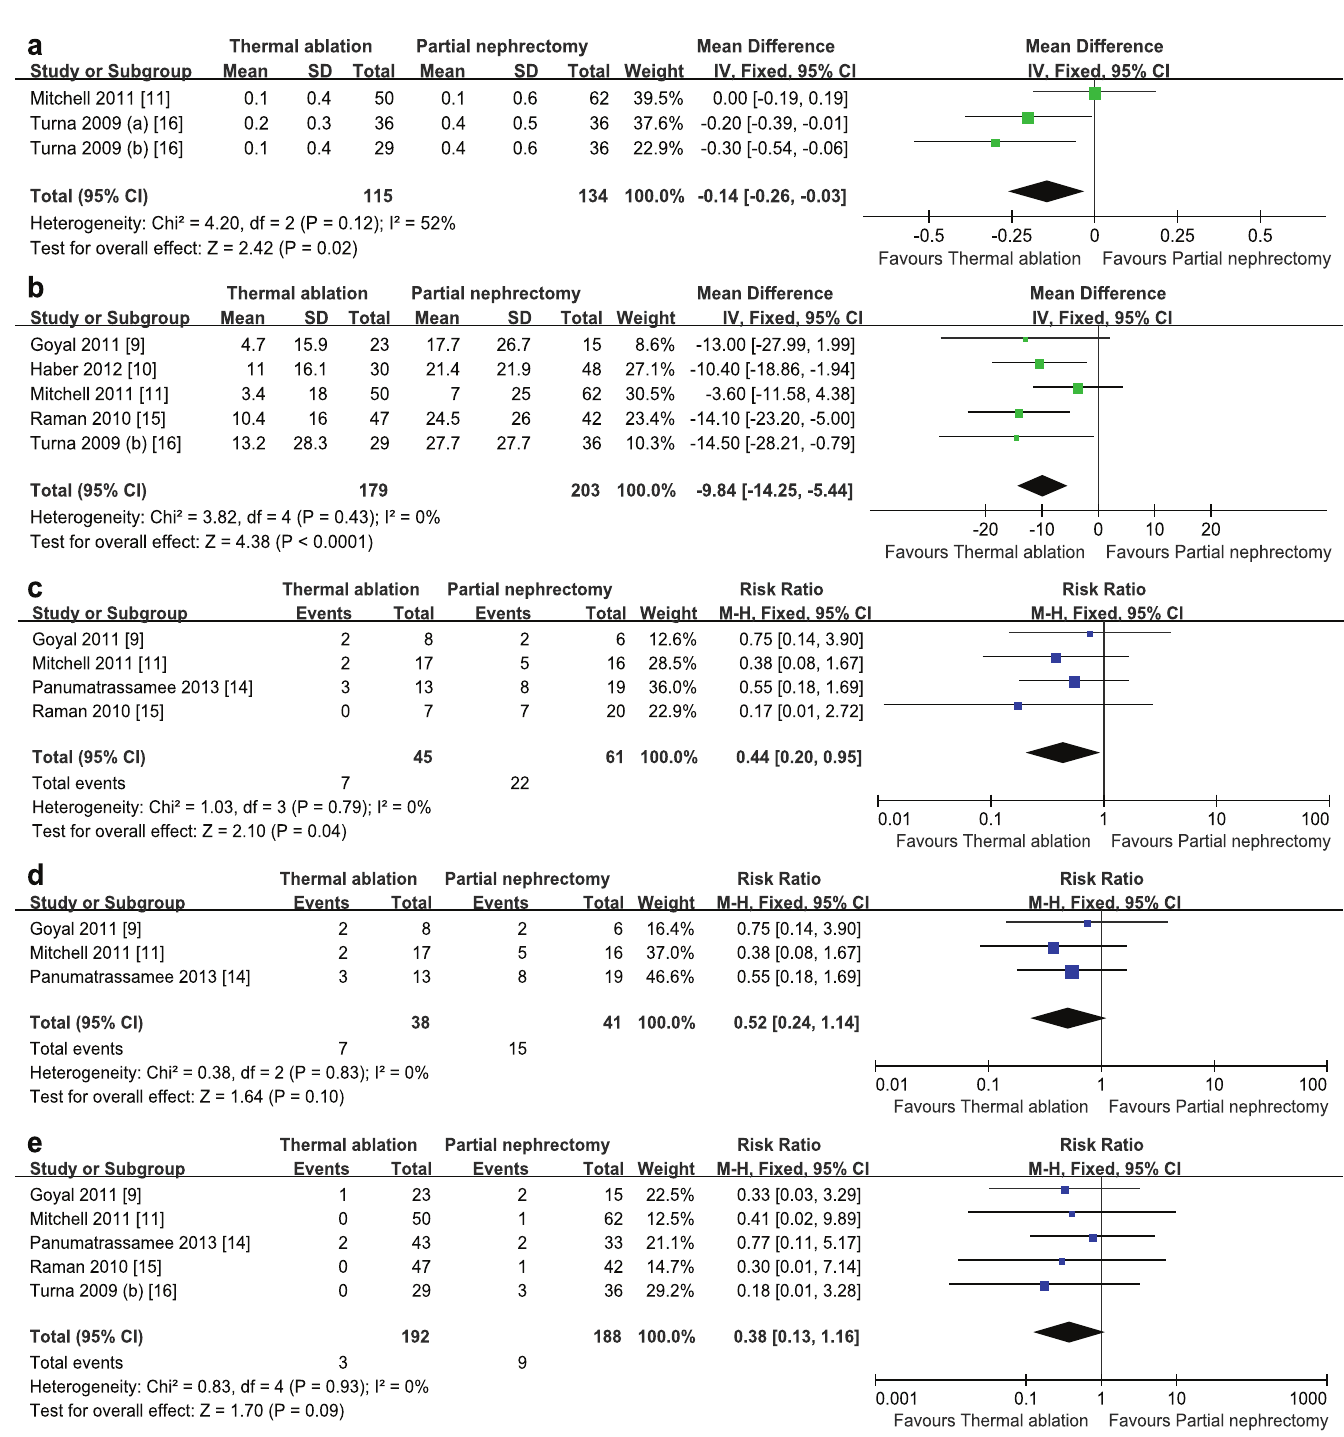
Fig 2. Forest plot and meta-analysis of renal functional outcomes: a) Increase of creatinine; b) Decrease of eGFR; c) Risk of new-set chronic kidney disease (CKD); d) Sensitivity analysis for risk of new-set CKD; e) Postoperative dialysis rate. IV = inverse variance method; M-H = Mantel- Haenszel method; CI = confidence